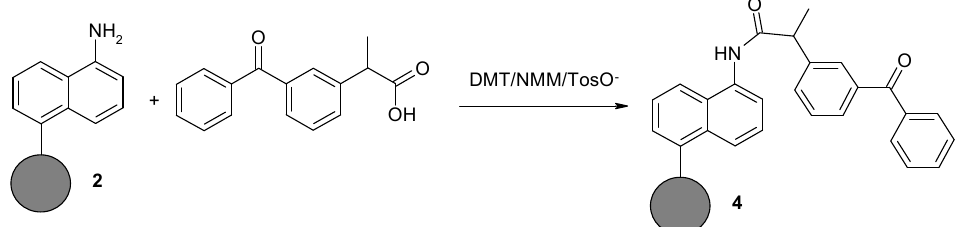
Figure 5. Reaction of modified NDPs 1 and 2 with methyl ester of 6-aminohexanoic acid and Ketoprofen using DMT/NMM/TosO − as a coupling reagent.